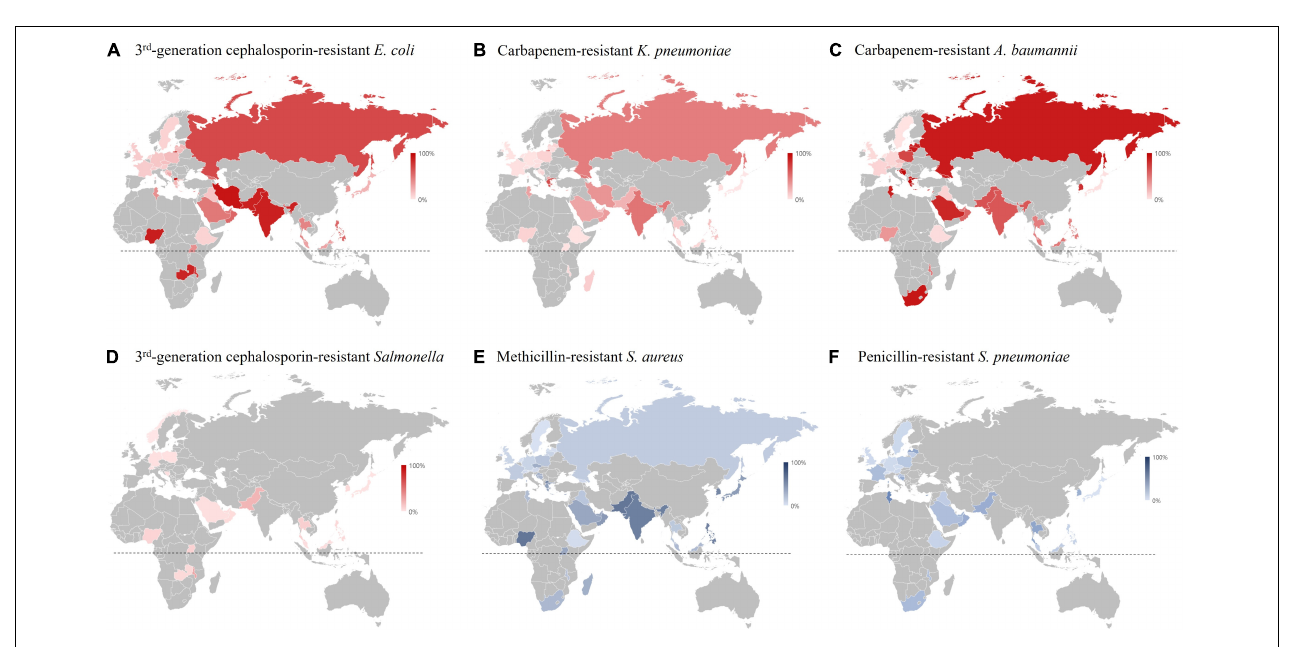
FIGURE 7 | Incidence of bacterial bloodstream infection (BSI) cases relative to the incidence of E. coli bloodstream infection cases (rI-EC) in 2017 based on the WHO GLASS report (World Health Organization [WHO], 2019). (A) rI-EC of K. pneumoniae BSI cases. (B) rI-EC of Salmonella BSI cases. (C) rI-EC of A. baumannii BSI cases. (D) rI-EC of S. aureus BSI cases. (E) rI-EC of S. pneumoniae BSI cases.The dotted lines indicate the equatorial line.